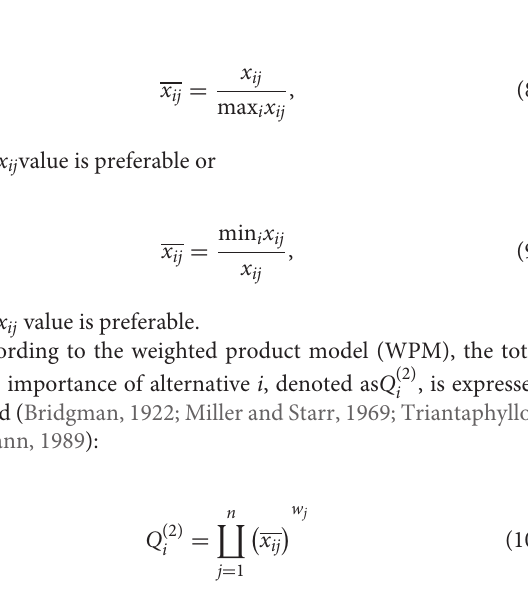
TABLE 3 | Summary of data requirement, data collection methods, and